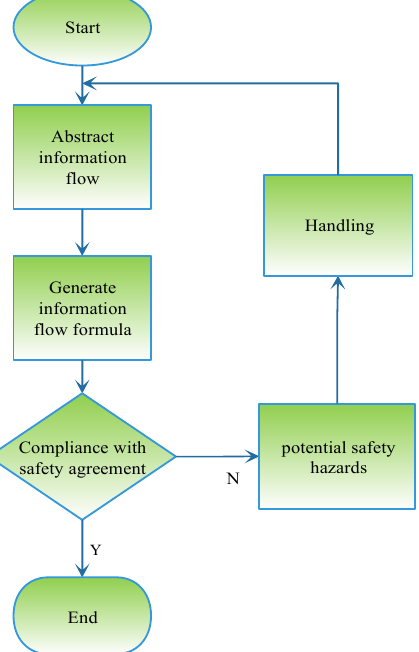
Figure 1. The flow chart of the information flow detection.